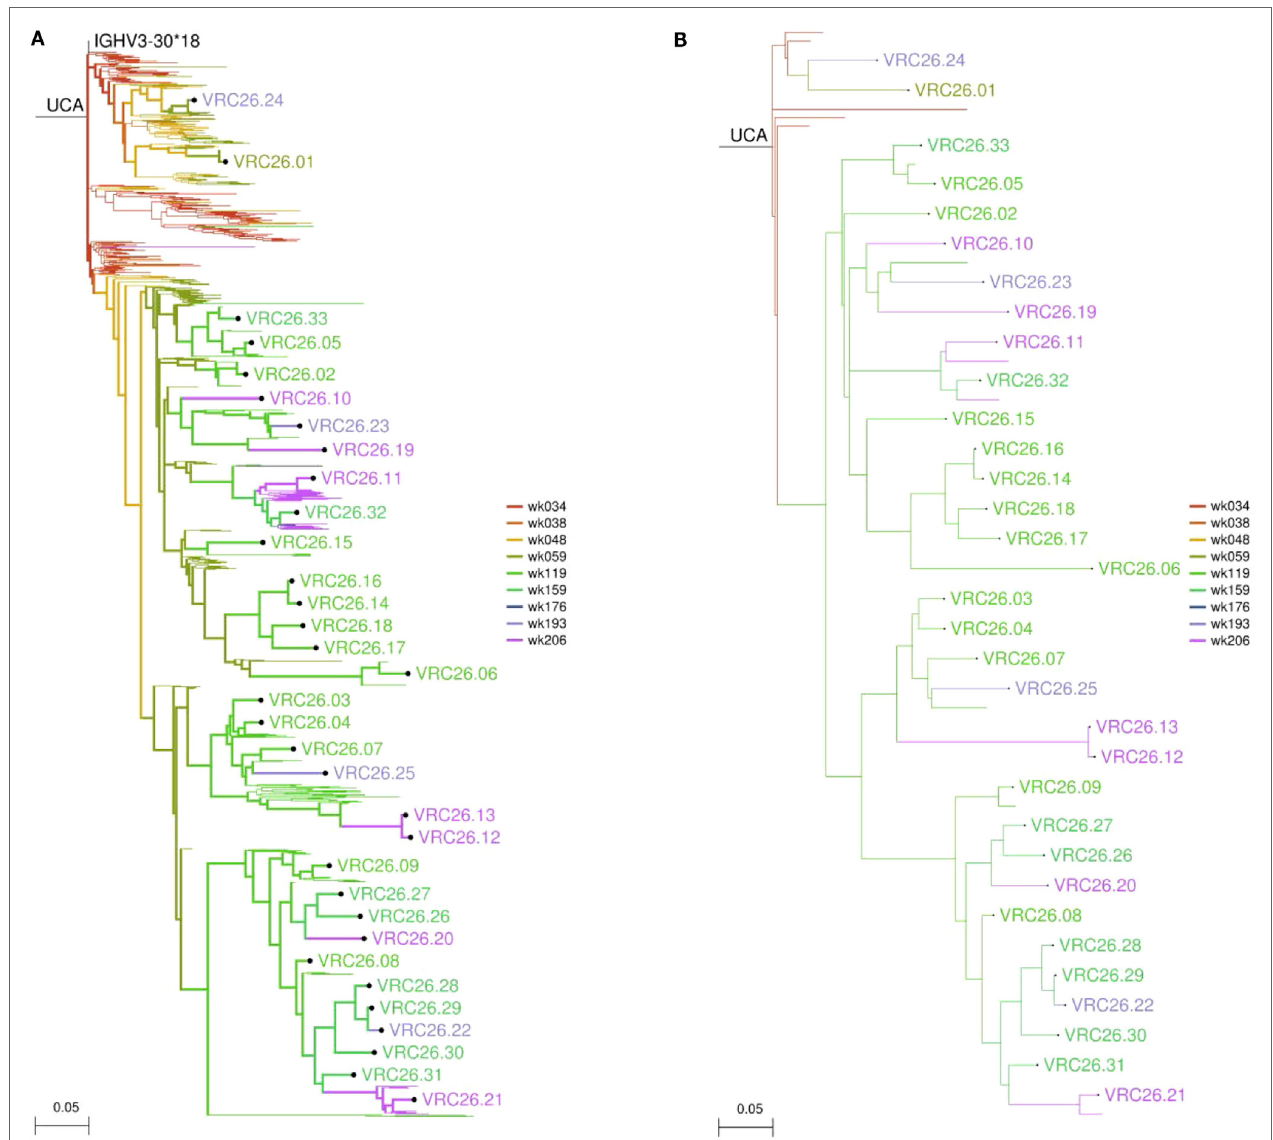
FIgURe 4 | sample figures for Module 3 analyses . (A) Longitudinal birthday tree of the CAP256-VRC26 lineage. This tree includes 384 NGS transcripts and the 33 isolated monoclonals. (B) The same tree displaying only 12 major branches derived from the NGS data and the 33 monoclonals. This allows the structure of the tree to be seen more